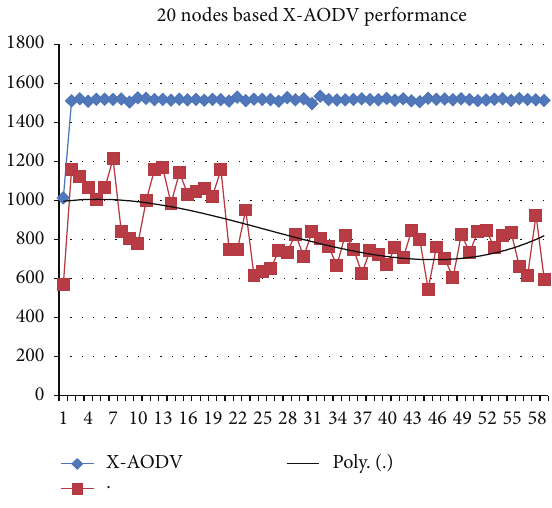
Figure 5: Cluster head selection in 20 good nodes.